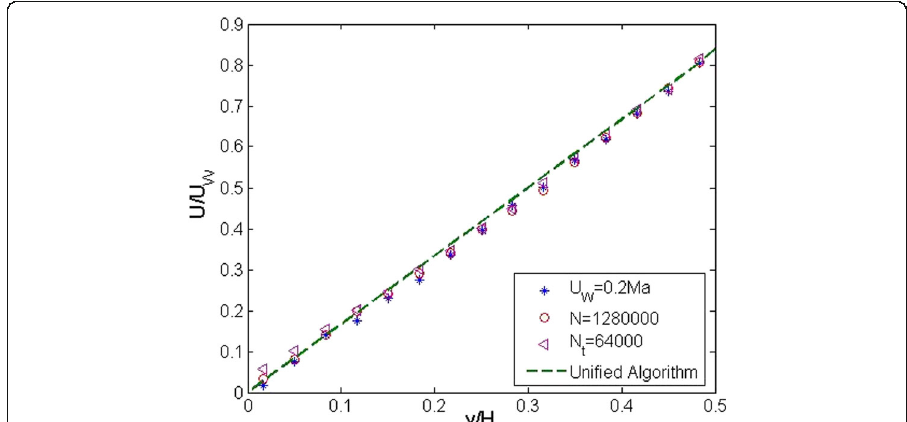
Fig. 2 DSMC results of flow velocity distribution under different conditions with comparison of